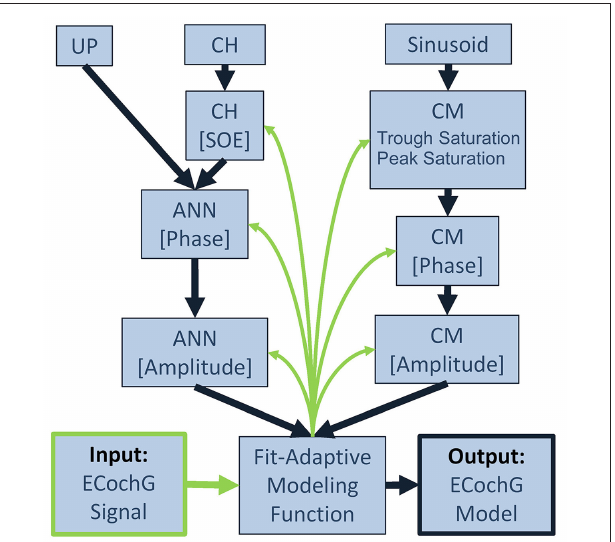
FIGURE 3 | Block diagram for fitting an observed ECochG to model parameters. The ongoing portion of a recorded/input ECochG signal (lower left corner) is the basis for a fit-adaptive modeling function (center, bottom). To estimate the hair cell contribution (right column), the fitting function generates a sinusoidal CM at the stimulus frequency and optimizes the coefficients for amplitude and phase, and saturation of the peaks and troughs of the response. To estimate the neural contribution (left column), a unit potential is convolved with a cycle histogram of variable spread of excitation (SOE) and the resulting ANN amplitude and phase are also optimized. The output of the model is the estimated ongoing ECochG and its associated CM and ANN parameters (lower right